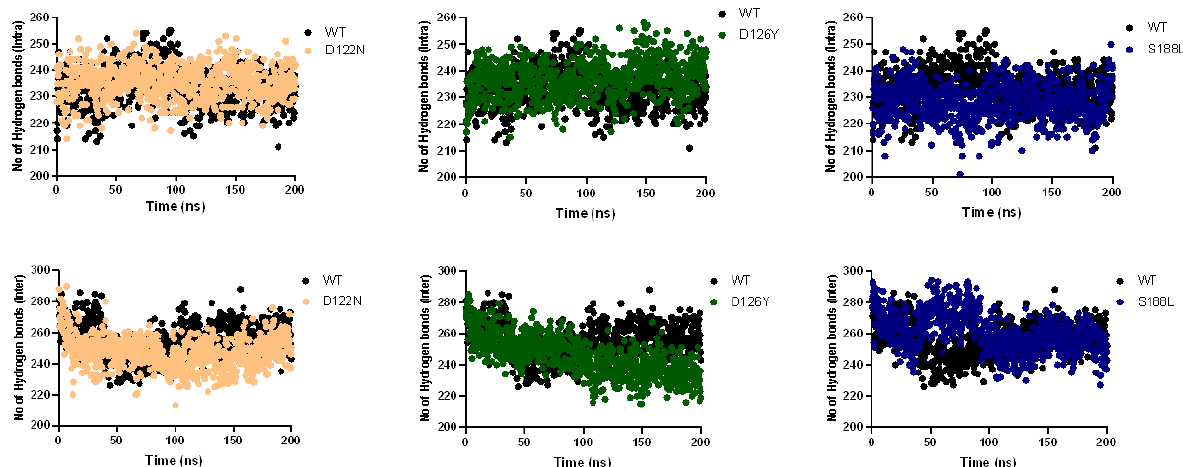
Figure 8. Hydrogen bond (intra- as well as intermolecular) analyses during a 200 ns simulation. The plots reveal the deviations in the hydrogen bond formation of wild-type MC4R and the mutants during the 200 ns simulation.